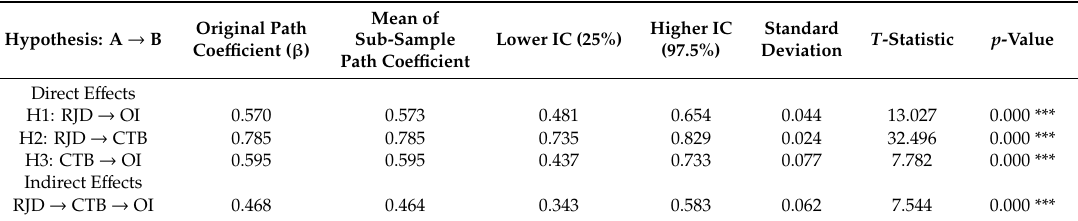
Table 6. Hypotheses